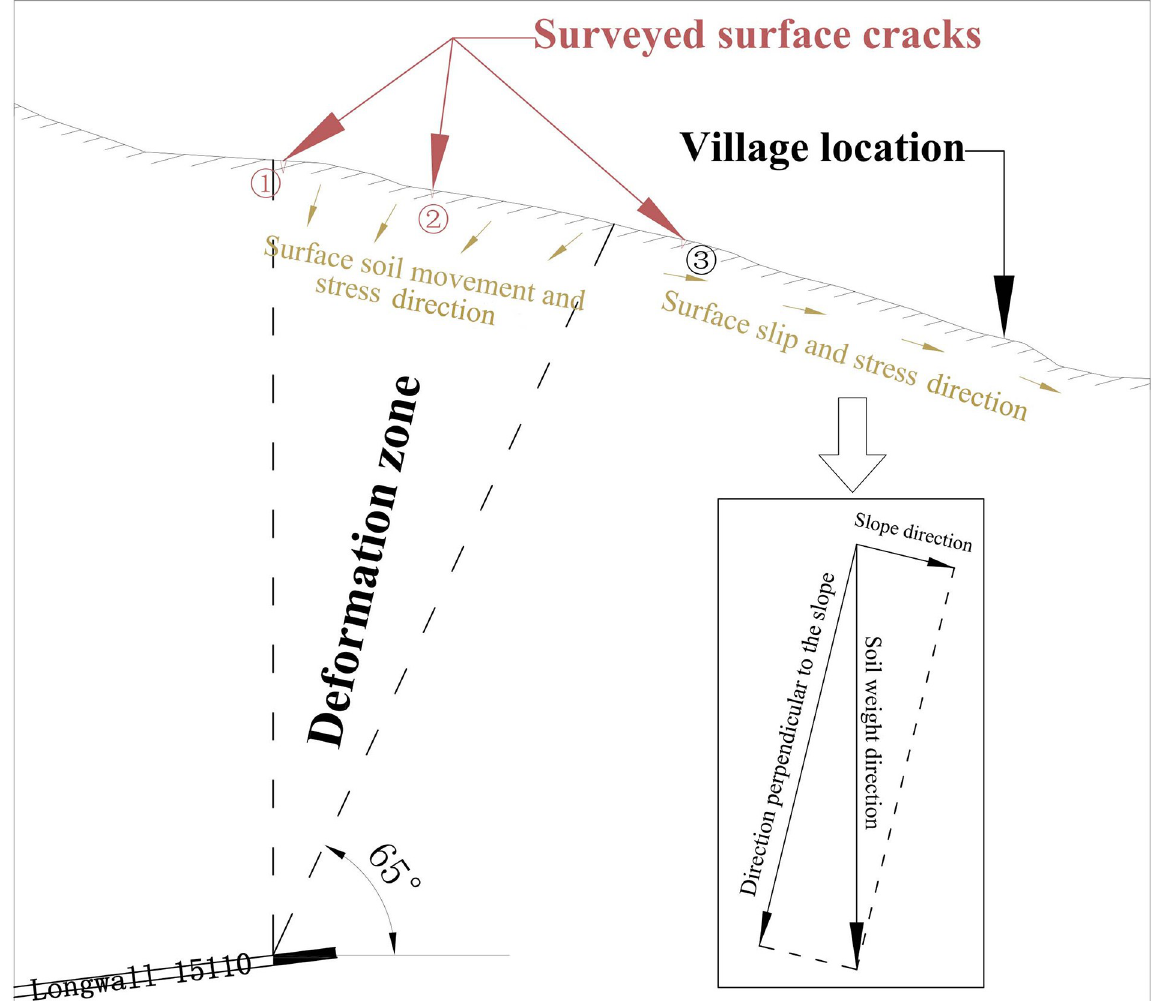
Fig 5. Diagram of surface soil layer stress direction.